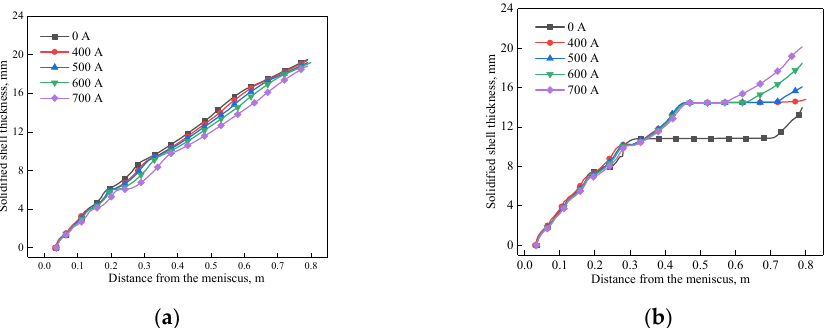
( c ) ( d ) Figure 7. 3D variation of solidified shell thickness along the casting direction under different EMS currents: ( a ) 0 A, ( b ) 400 A, ( c ) 700 A, ( d ) schematic of transverse flow near jet flow with EMS. As shown in Figure 7, the initial solidified shell was generated at − 0.042 m distance